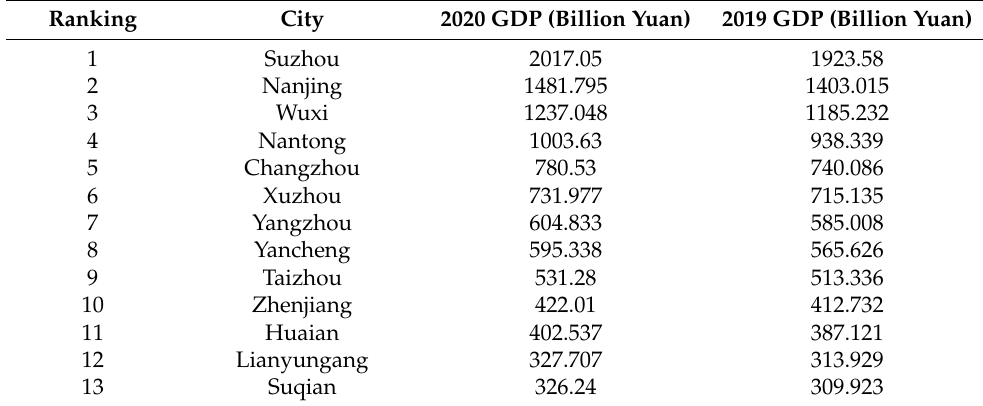
Table 5. GDP rankings of 13 prefecture-level cities in Jiangsu Province (data from the National Bu- reau of Statistics of China, http://www.stats.gov.cn/, accessed on 10 March 2022). Ranking